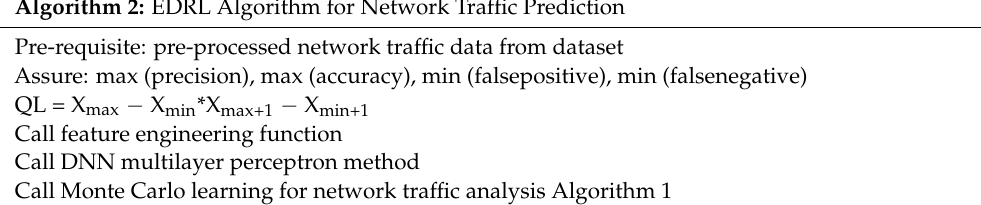
Algorithm 2: EDRL Algorithm for Network Traffic